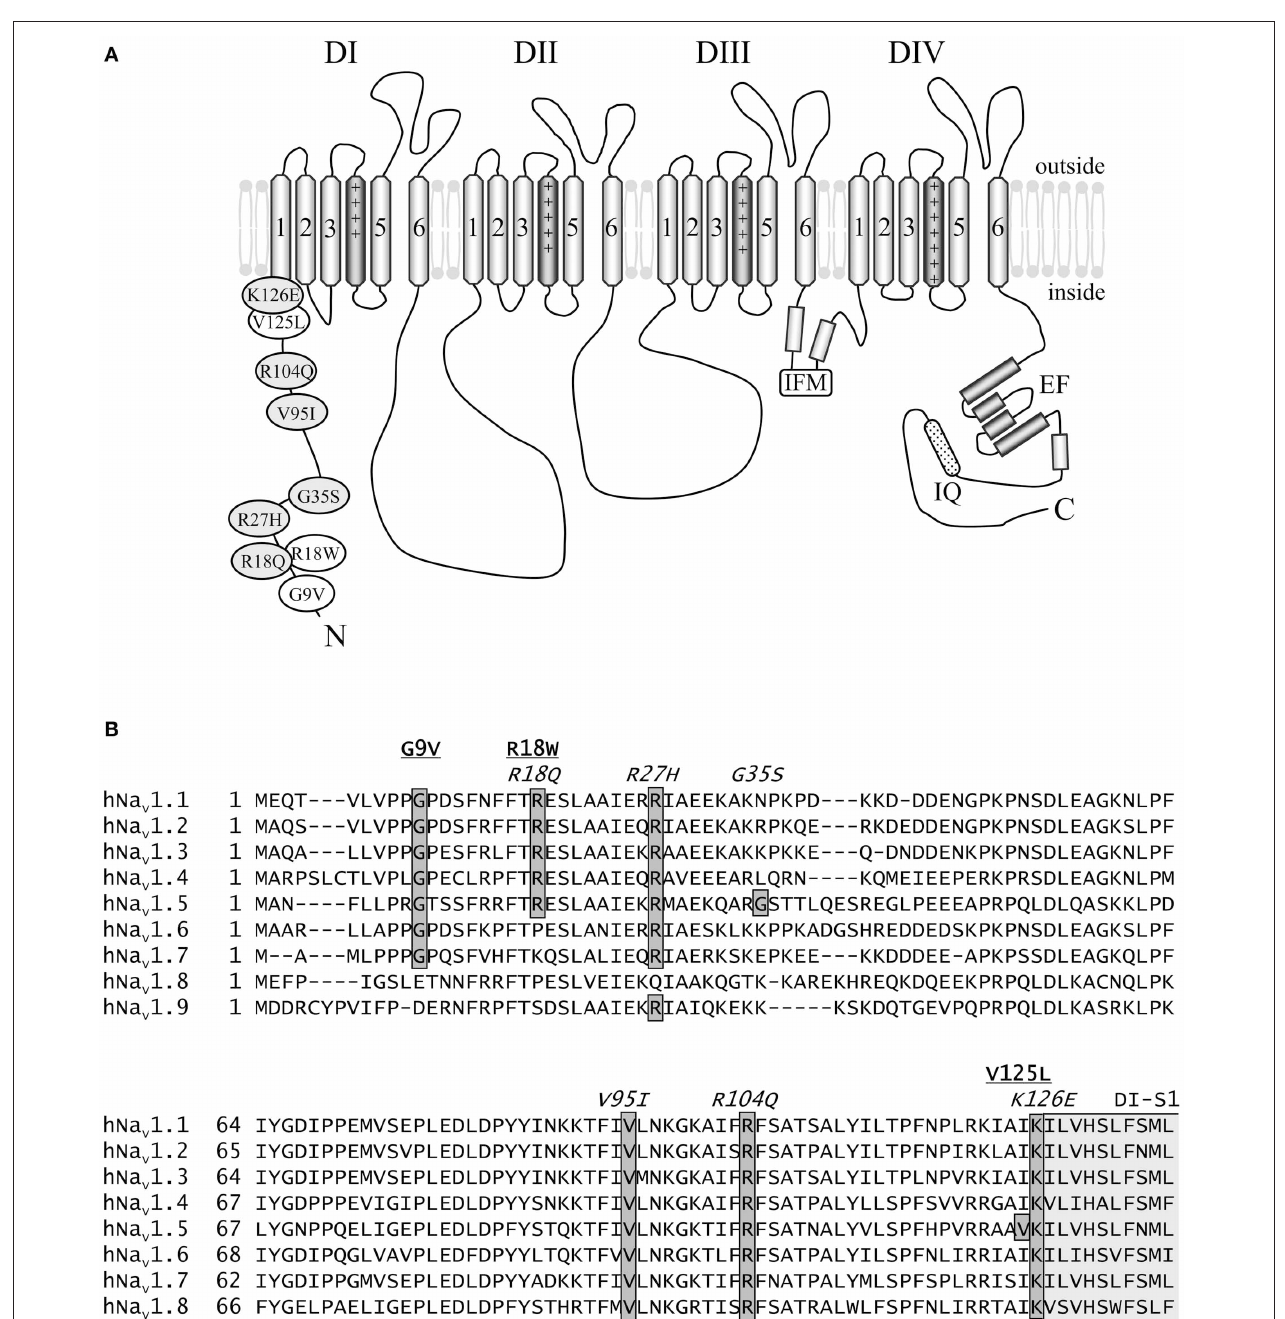
FIGURE 1 | Schematic representation of hNa v 1.5 and the N-terminal mutations investigated in this study. (A) Proposed hNa v 1.5 topology. Affected residues are indicated in white (LQT3) and light grey (BrS). The schematic structure also highlights some important structural features (DI to DIV—domain I to IV, IFM—residues isoleucine, phenylalanine, and methionine of the inactivation gate, IQ—calmodulin binding motif, EF—Ca ++ binding EF hand domain). (B) Alignment of the N-terminal sequences of human Nav1.1—Nav1.9. Mutations associated with LQT3 or BrS are underlined or indicated in italics, respectively. Most of the eight affected residues are conserved among